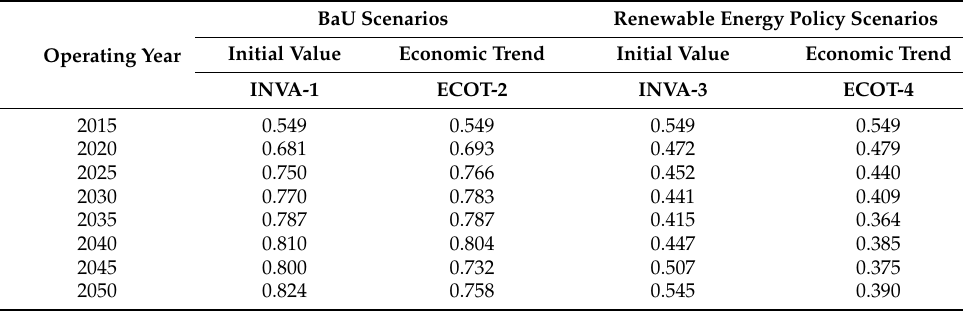
Table 4. Electricity carbon intensity under renewable energy policy scenario.